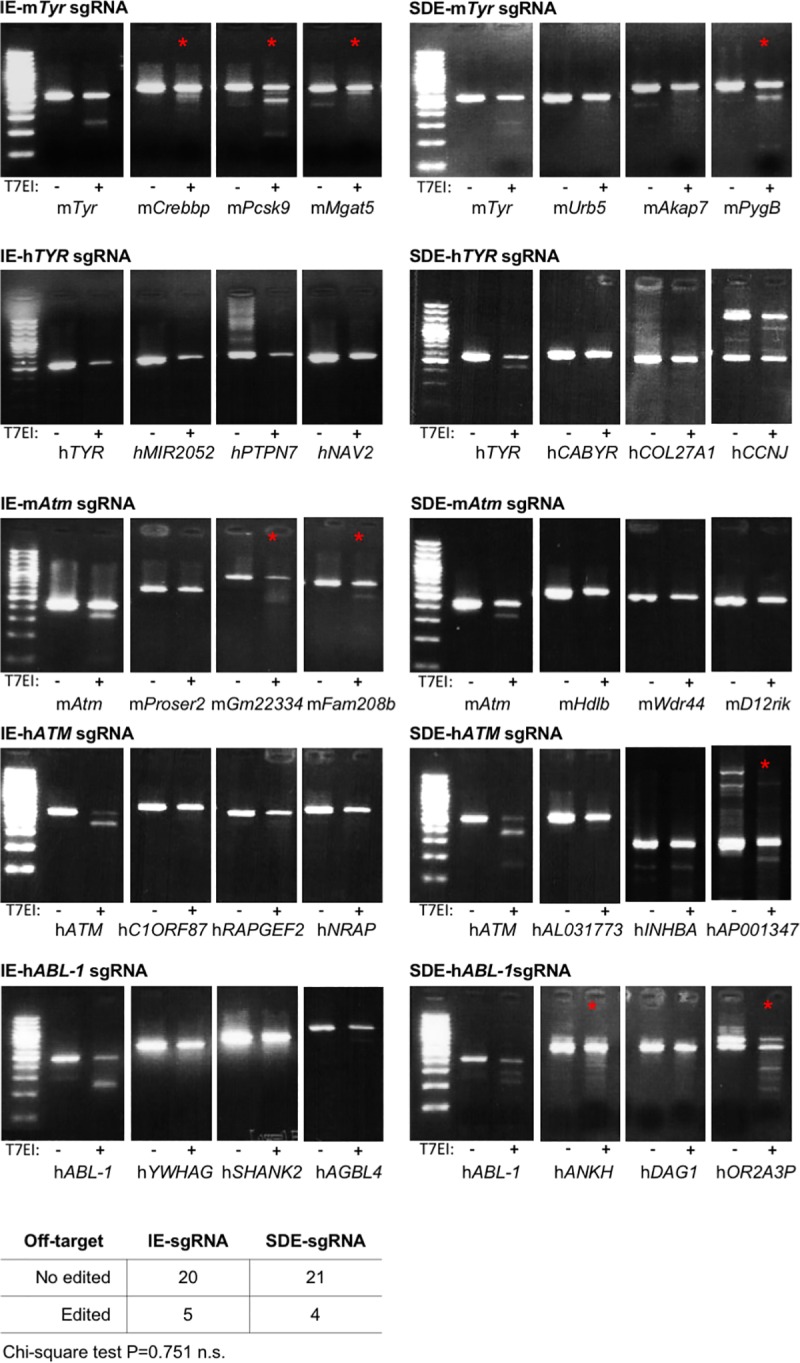
Off-targets analysis of sgRNAs.Surveyor analysis of the top 5 predicted off-targets for each sgRNA used. Panel shows amplified sequence of target and 3 representative off-targets, non-treated and treated with T7 endonuclease I. Digestion reveals genome edition (red asterisk) when the off-target sequence carries some mutations. Table shows overall results from all off-targets analyzed. No differences were observed in number of edited off-targets by IE-sgRNAs compared with SDE-sgRNAs (Chi-square test P = 0.751 n.s.).